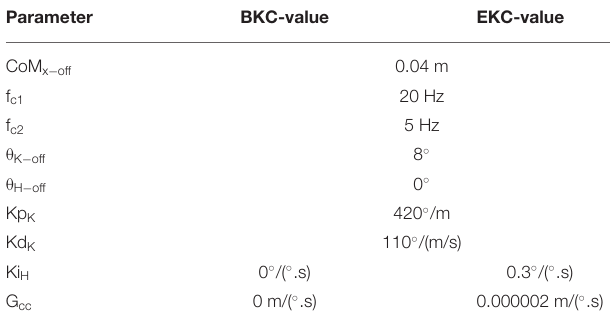
TABLE 1 | Controller parameters